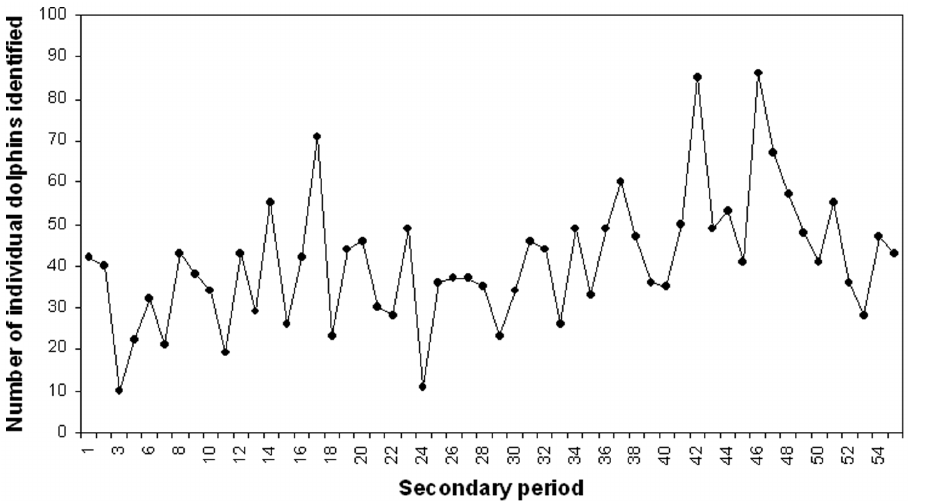
Figure 3. Number of individual dolphins (juveniles and adults) identified in each secondary period March 2007-November 2009.